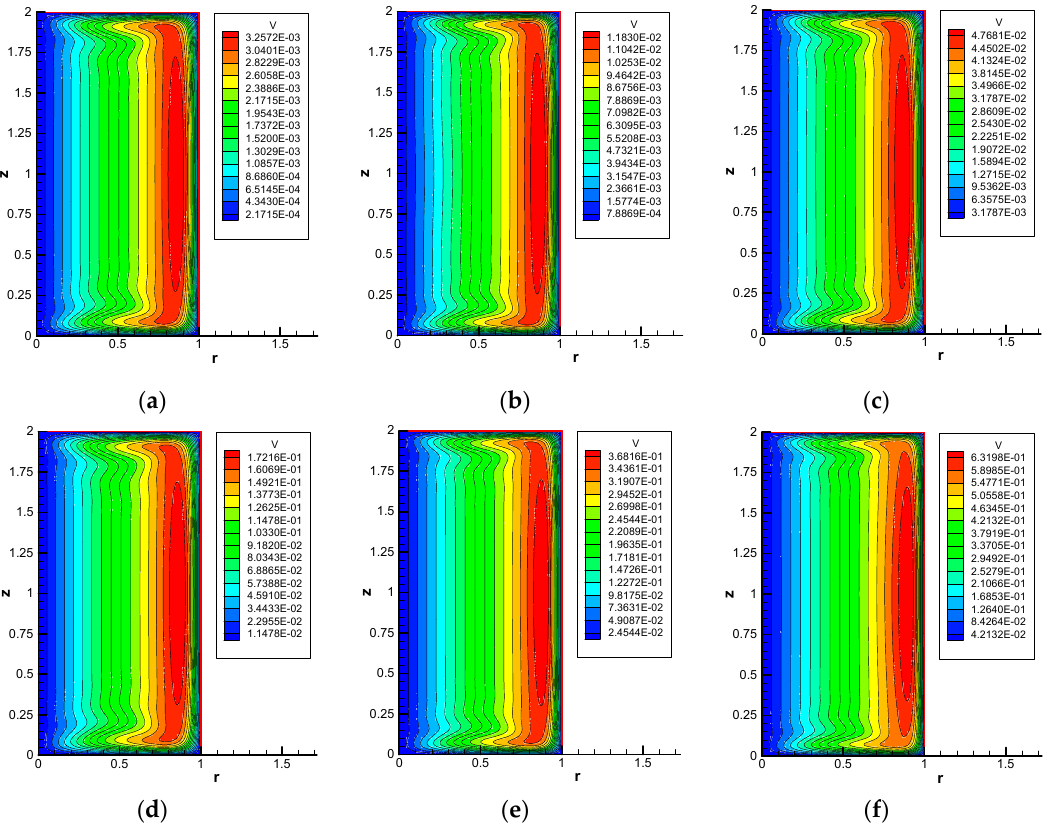
Figure 12. Contour maps of the azimuthal velocity for various combinations of the Hartmann number and the Reynolds number at m = 1. ( a ) Ha = 1, Re = 300000; ( b ) Ha = 2, Re = 100000; ( c ) Ha = 4, Re = 22500; ( d ) Ha = 8, Re = 5000; ( e ) Ha = 15, Re = 3500; ( f ) Ha = 30, Re = 2410.